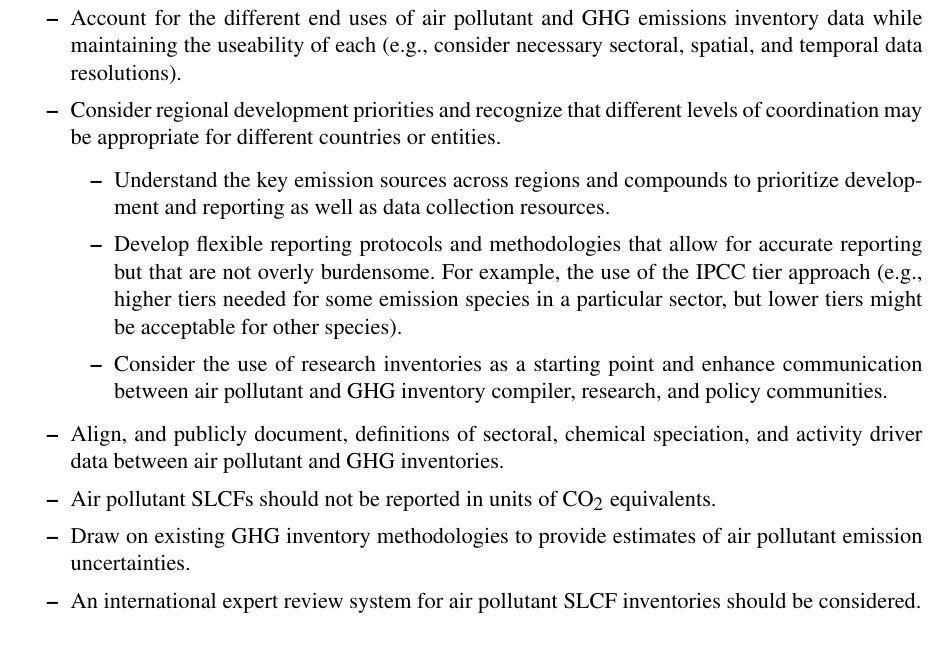
Table 1. Recommendations for coordination